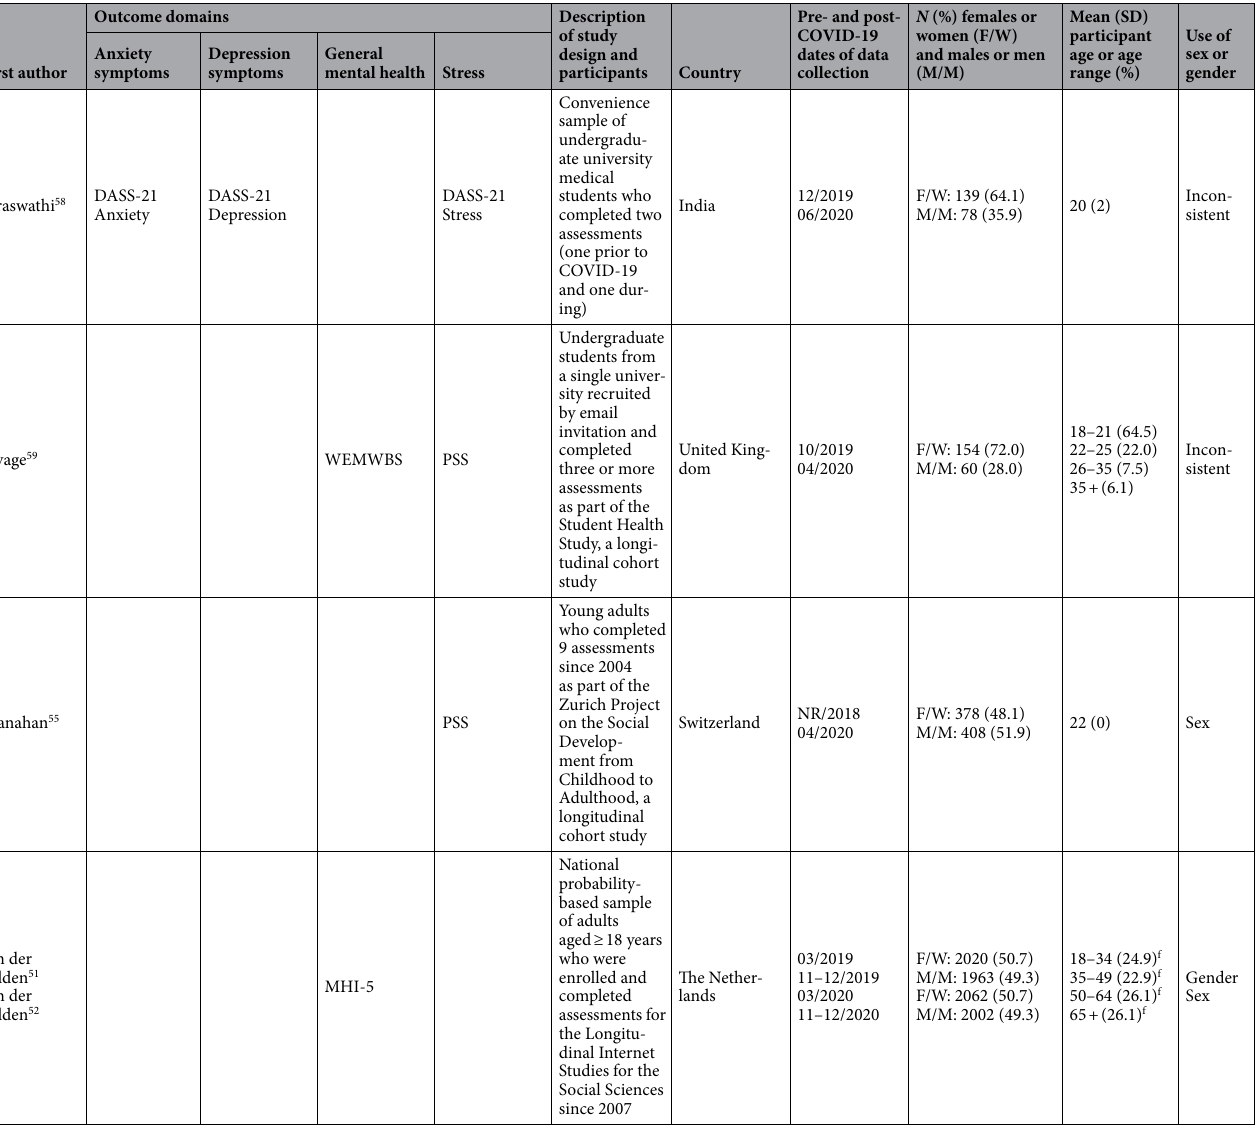
Table 1. Characteristics of included studies ( N = 12). DASS-21 Anxiety = Depression, Anxiety, and Stress Scale—Anxiety subscale; DASS-21 Depression = Depression, Anxiety, and Stress Scale—Depression subscale; DASS-21 Stress = Depression, Anxiety, and Stress Scale—Stress subscale, GAD-7 Generalized Anxiety Disorder-7; GHQ-12 = General Health Questionnaire-12; MHI-5 = Mental Health Index-5; PANAS-NA = Positive and Negative Affect Schedule—Negative affect subscale; PROMIS Anxiety = Patient-Reported Outcomes Measurement Information System—Anxiety subscale; PROMIS Depression =